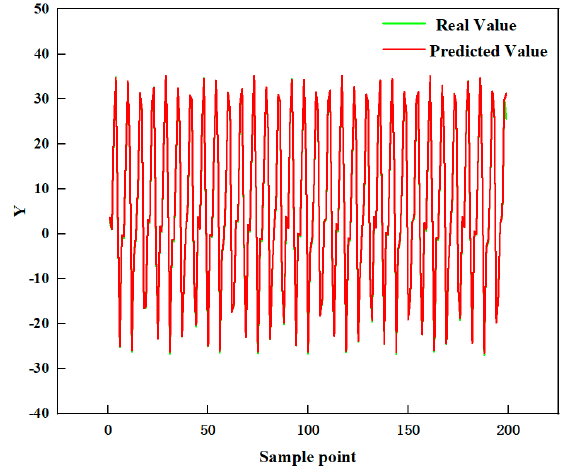
Figure 6. The prediction of Y value.